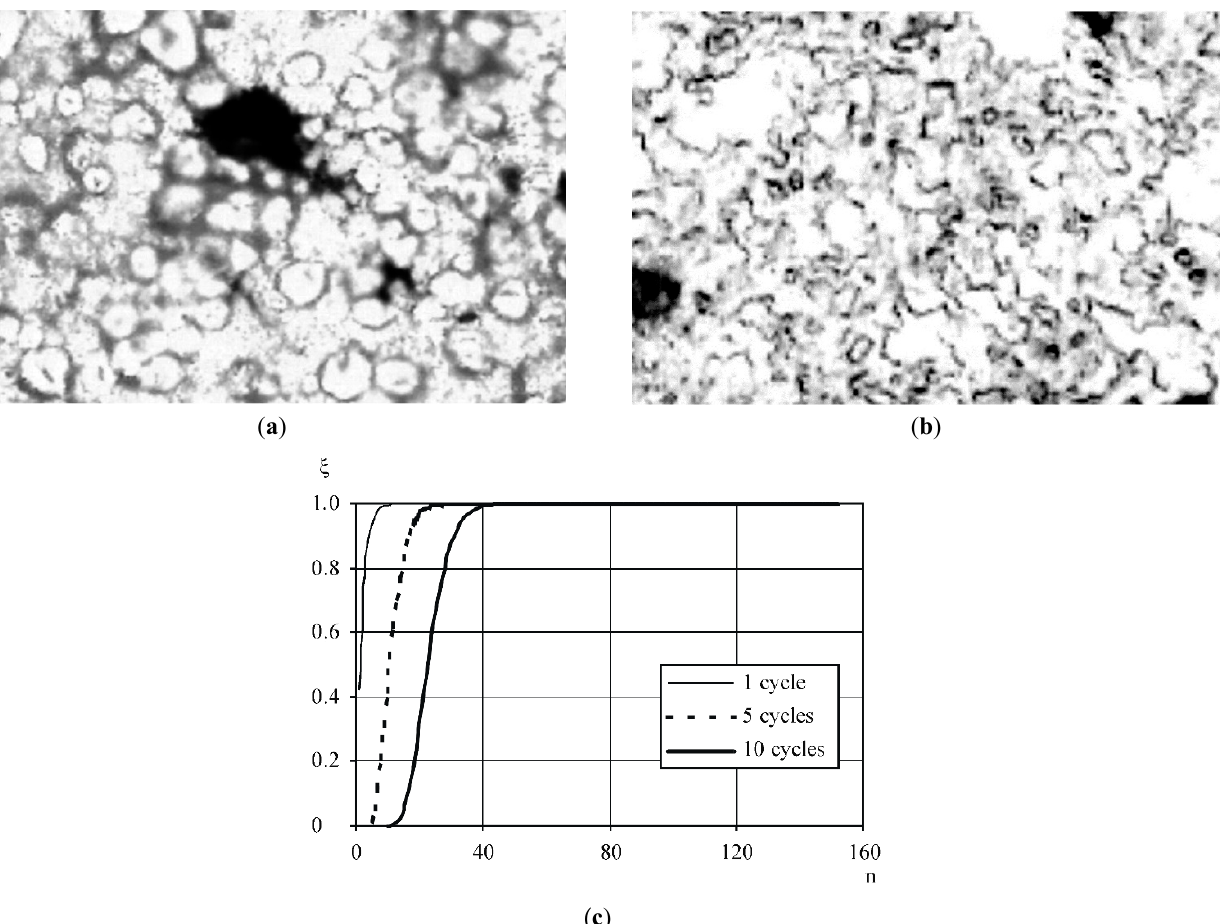
Figure 15. Microstructure of the “Yagidka” cream cheese mass: ( a ) the microstructure of the cream cheese mass before treatment; ( b ) the microstructure of the cream cheese mass after 45 cycles of treatment; ( c ) the level of mechanical treatment of the product as a function of the number of processing